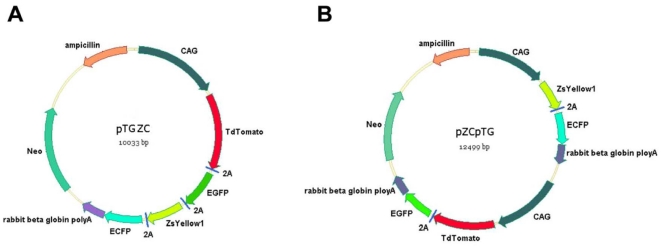
Maps of the pTGZC (A) and pZCpTG (B) vectors.